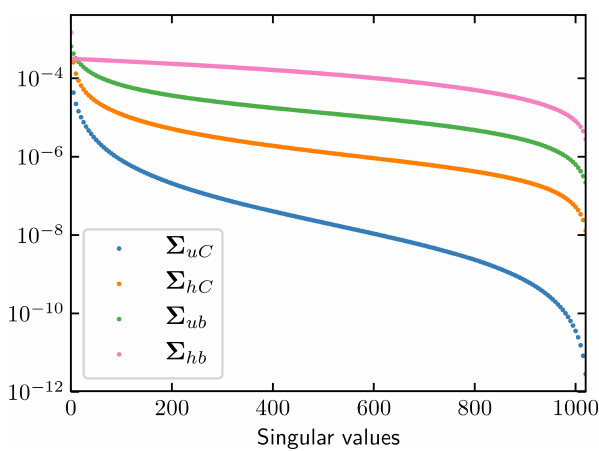
Figure 9. The singular values of the transfer matrices W uC , W hC , W ub , and W hb